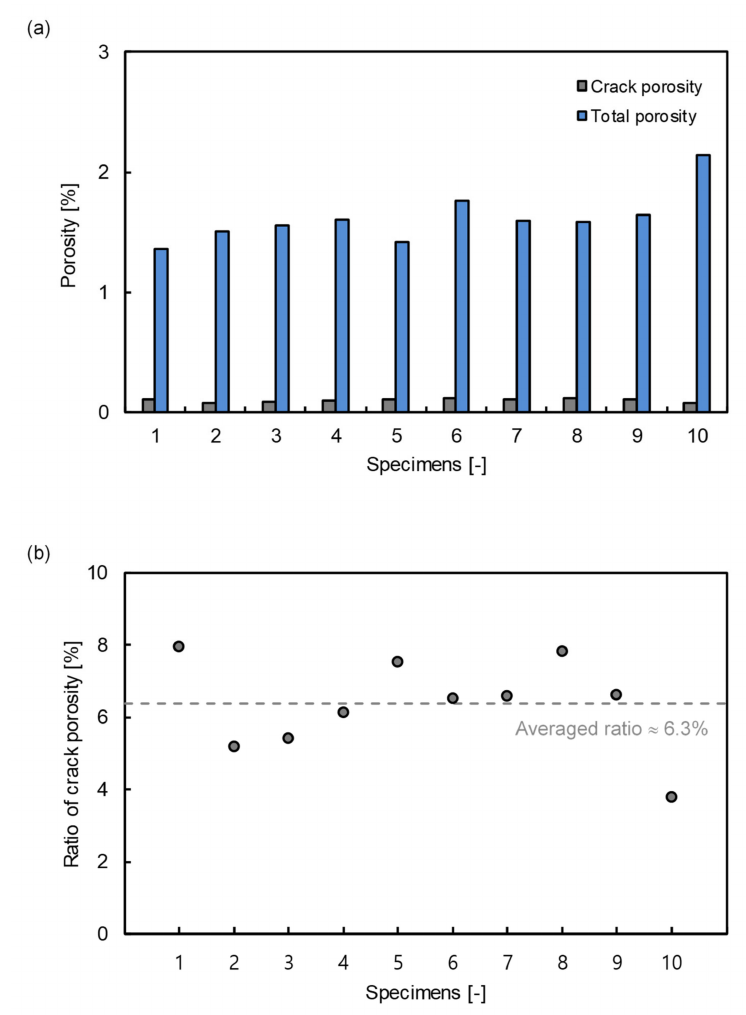
Figure 14. Distribution of porosity: ( a ) comparison between total porosity and crack porosity; ( b ) ratio of crack porosity as a function of total porosity. The 1, 2, 3, 4, 5, 6, 7, 8, 9, and 10 denote samples albite 1, albite 2, albite 3, albite 4, quartz 1, quartz 2, quartz 3, biotite, calcite, and chlorite,